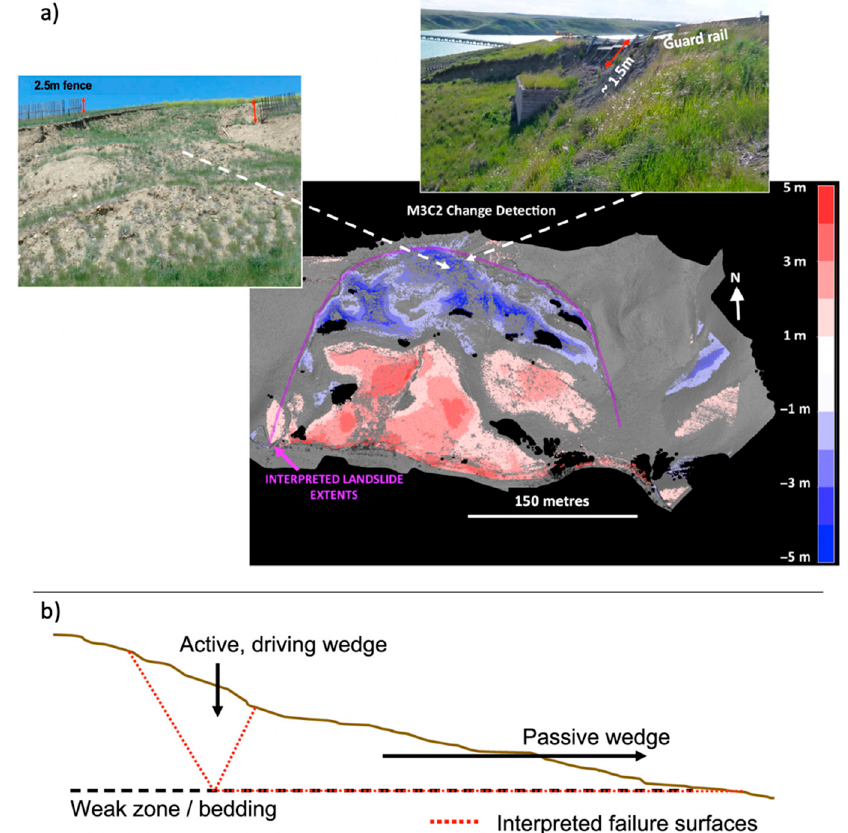
Figure 3. Change detection results at the Chin Coulee landslide ( a ) and interpreted landslide mechanism ( b ). Adapted from [30].